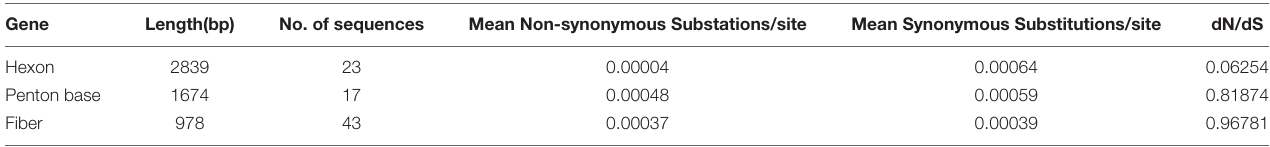
The mean numbers of non-synonymous (dN) and synonymous(dS) substitutions per site from between sequences were noted and dN/dS were calculated. This selection pressure analysis was conducted using the maximum-composite-likelihood model, and included nucleotide sequences from 23 hexon, 43 fiber, and 17 penton base genes of HAdV-55 available from GenBank. All positions containing gaps were eliminated automatically. Evolutionary analyses were performed with MEGA 5.05